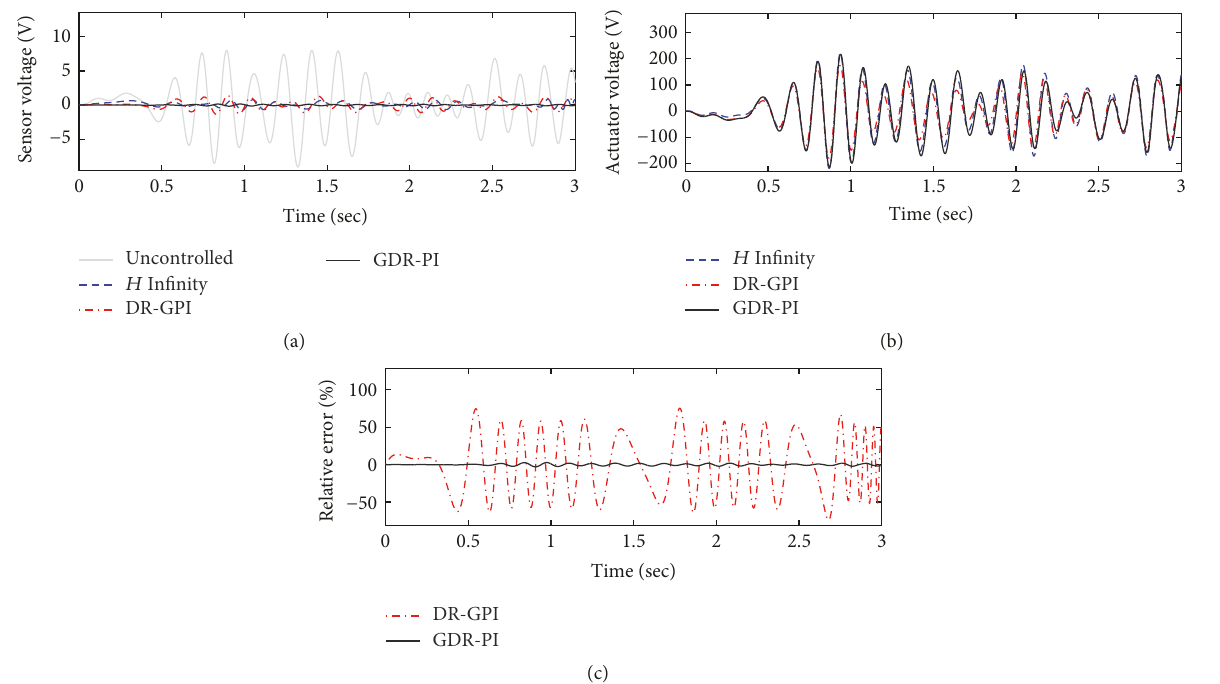
Figure 10: The time domain response of the controlled and uncontrolled smart beam under a harmonic disturbance with a randomly varying frequency: (a) sensor output, (b) control input, and (c) relative error of estimated